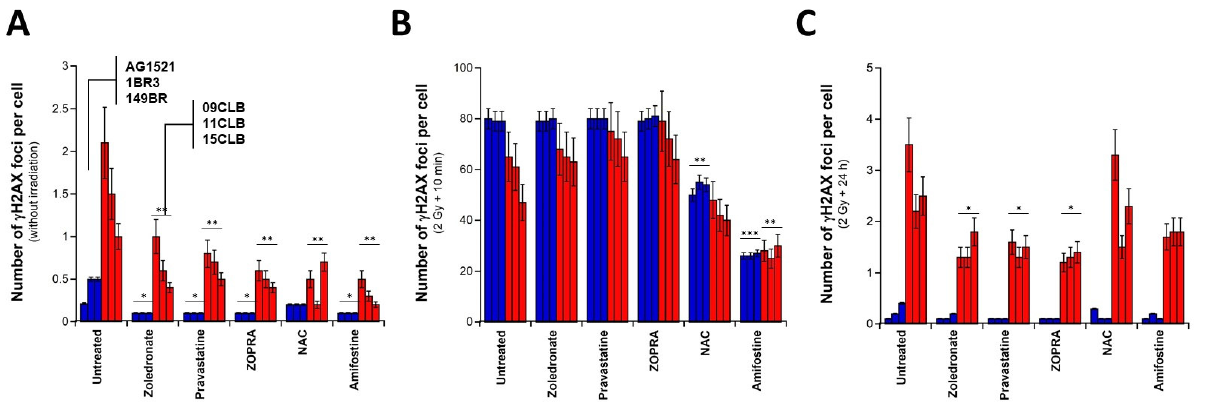
Figure 4. Radioprotective effect of a pretreatment with zoledronate, pravastatine and ZOPRA. Number of γ H2AX foci per cell assessed in the indicated pretreatment and after the indicated pretreatment ( A ), followed by 2 Gy X-rays and 10 min ( B ) or 24 h ( C ) incubation. Each bar represents the mean ± standard error (SEM) of at least three replicates. The NAC and amifostine data are those already shown in Figures 3 and 4 with pretreatment of 300 mM NAC and 96 mM amifostine. one, two and three asterisks indicate p < 0.05, p < 0.01 and p < 0.001, respectively, by comparison with untreated controls.